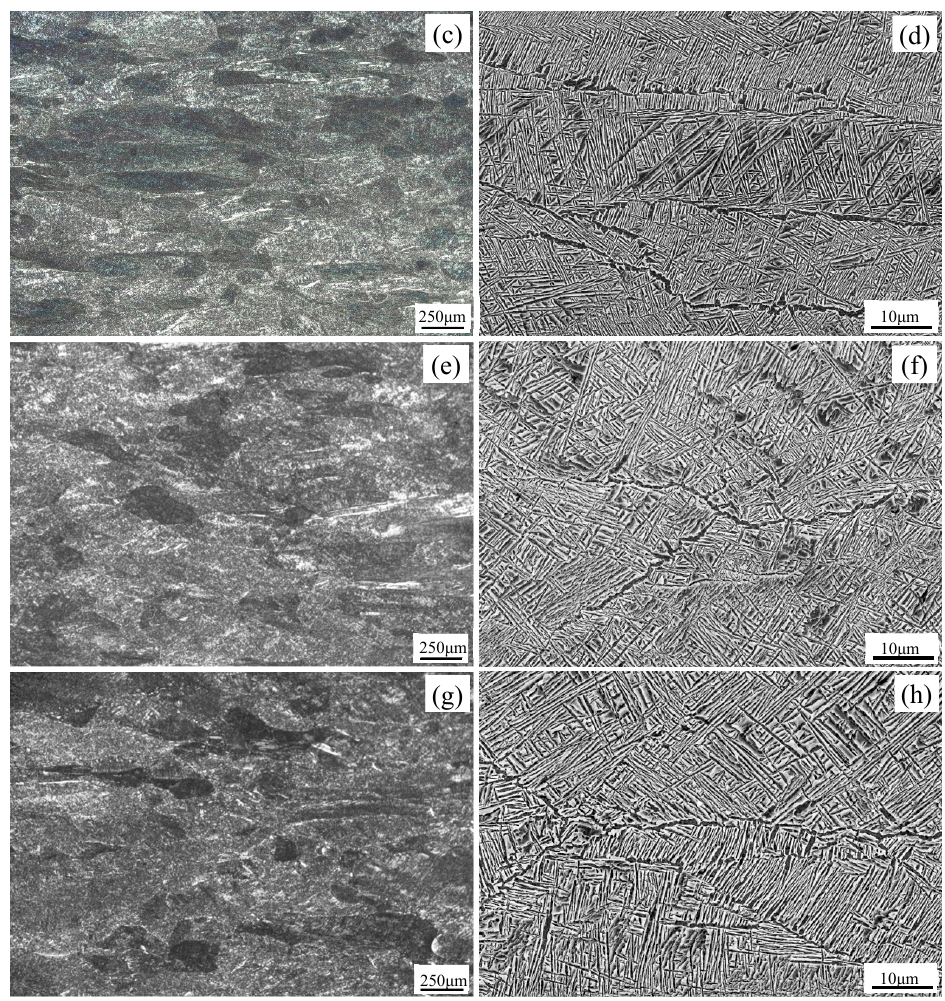
Figure 4. Microstructure evolution of Ti17 titanium alloy after different aging treatment after rolling at 920 °C temperature: ( a ) ( b ) 540 °C, ( c ) ( d ) 570 °C, ( e ) ( f ) 600 °C and ( g ) ( h ) 630 °C.